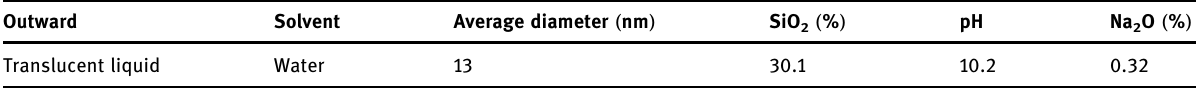
Table 2: Physical and chemical properties of nano - SiO 2 Outward